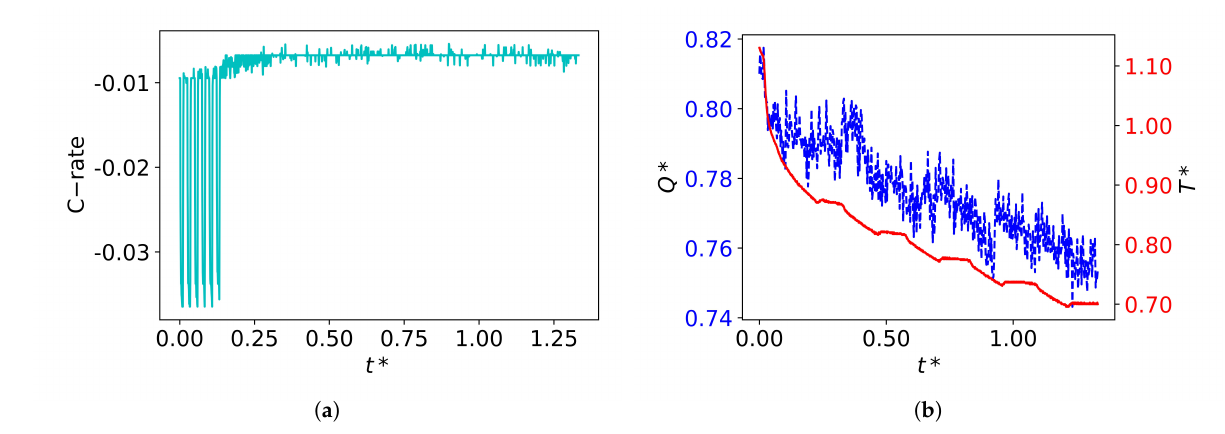
Figure 5. Case 4 test scenario: ( a ) Current profile and ( b ) inlet volumetric flow rate ( Q ∗ ) and temperature of the coolant ( T ∗ )